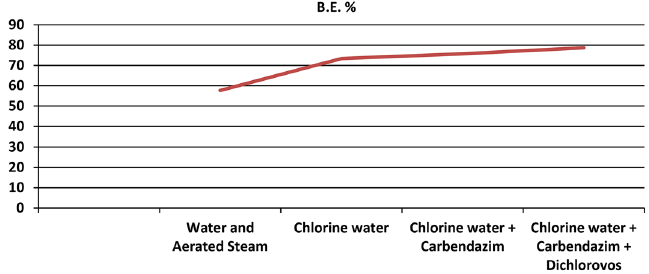
Figure 4. BE% obtained from substrates treated with different sterilization methods.